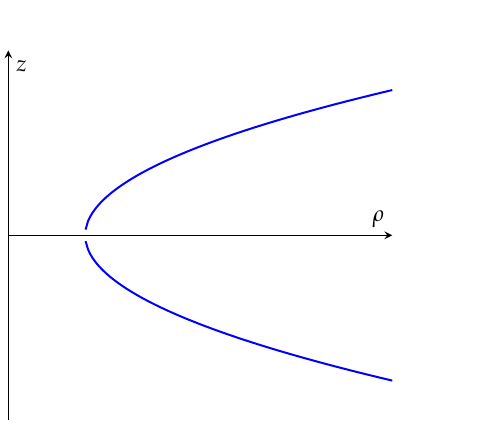
Figure 1. The embedding diagram. The function ρ ( z ) is shown on the left panel, and the surface obtained by rotating the curve ρ ( z ) about the axis Oz is shown on the right